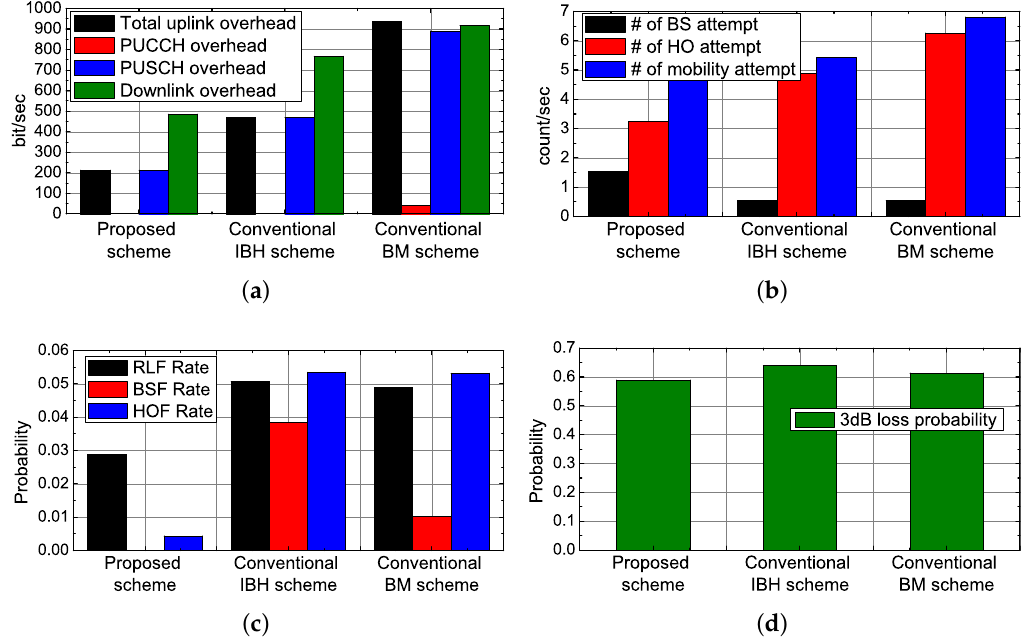
Figure 5. Results under the UDN scenario. ( a ) overhead performance, ( b ) mobility attempts, ( c ) mobility failure rates, ( d ) 3-dB loss